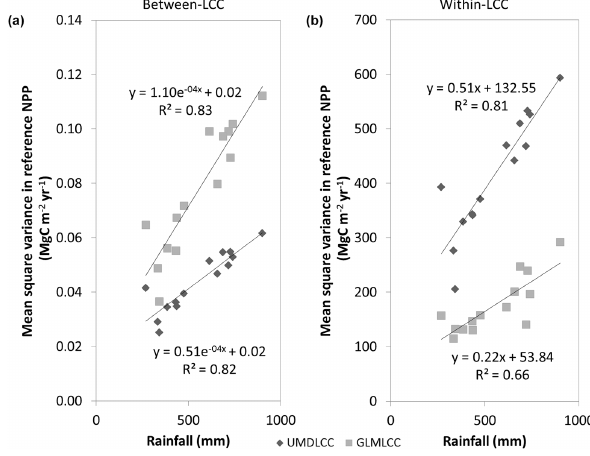
Figure 4. Mean square variance in reference NPP (MgC m − 2 yr − 1 ) for UMDLCC and GLMLCC in relation to rainfall: (a) “between- LCC” and (b) “within-LCC” with best-fit regression lines for each year 2000 to